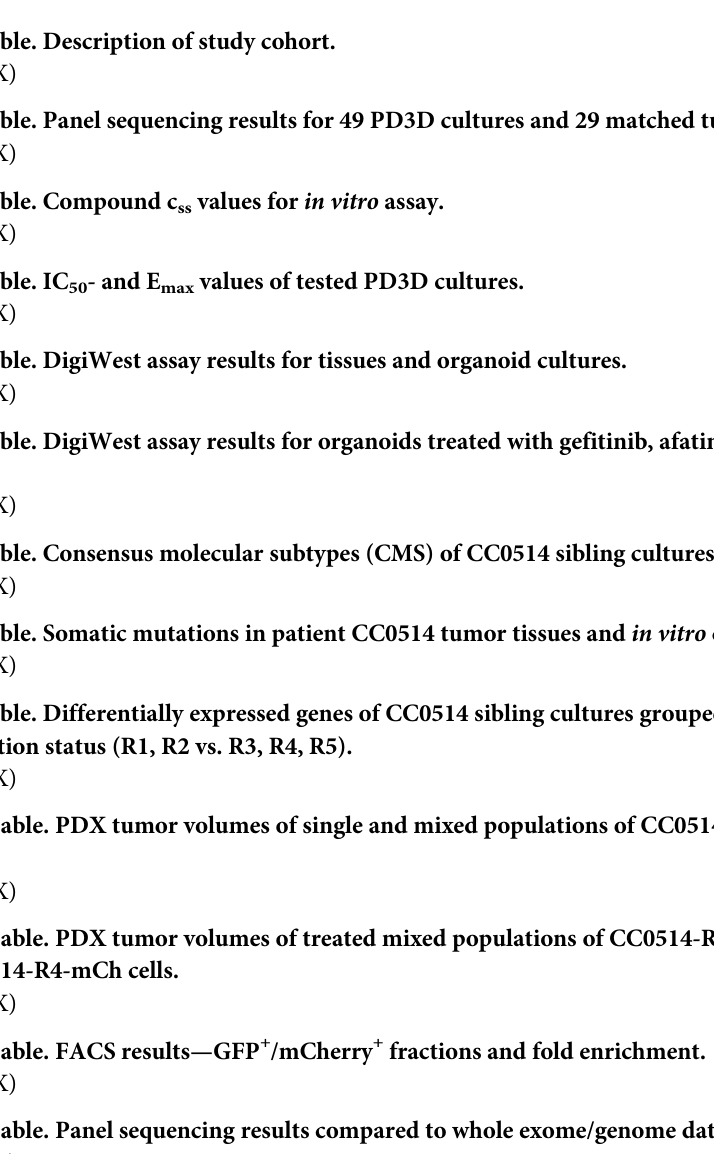
S12 Table. FACS results—GFP + /mCherry + fractions and fold enrichment. S13 Table. Panel sequencing results compared to whole exome/genome data from [11].